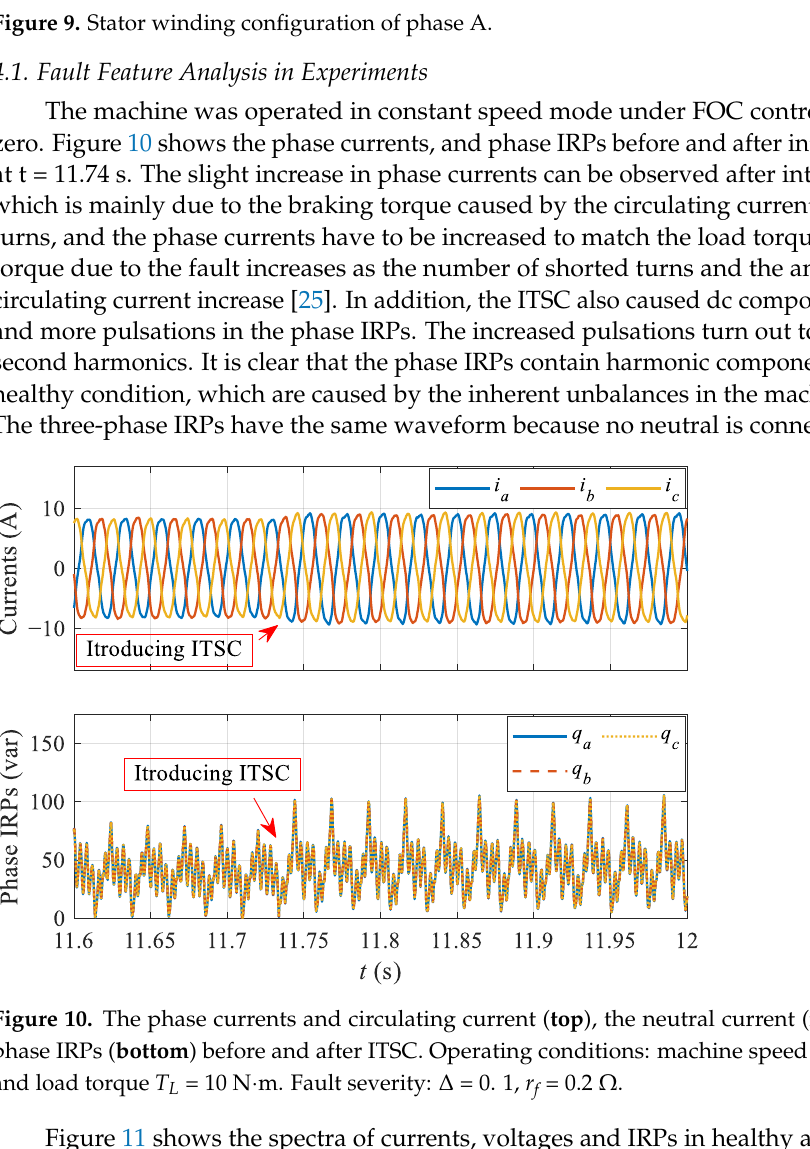
Figure 9. Stator winding configuration of phase A.